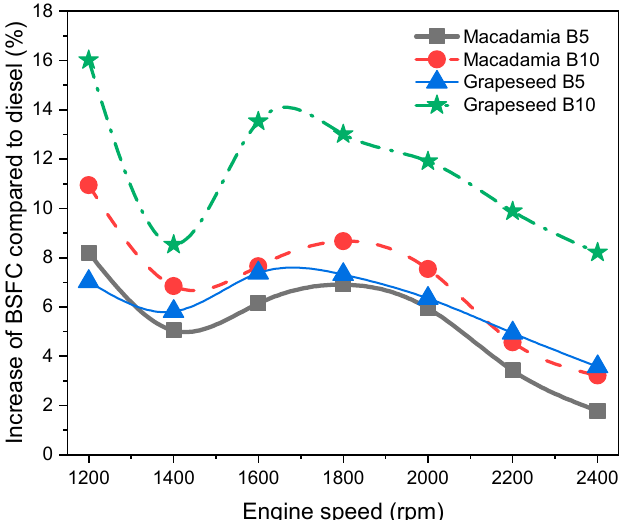
Figure 3. Comparison of the brake specific fuel consumption (BSFC) increase using B5 and B10 biodiesel blends.